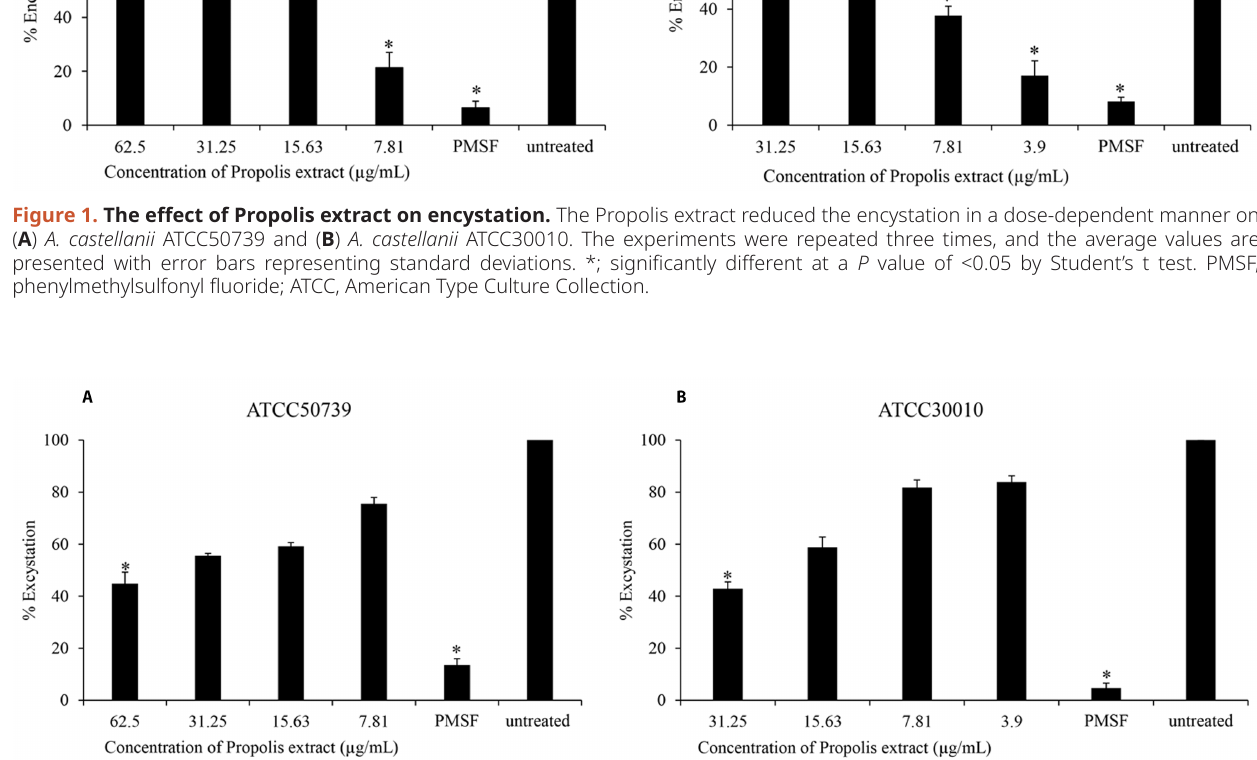
Figure 2. The effect of Propolis extract on excystation. Propolis extract reduced the excystation on ( A ) A. castellanii ATCC50739 and ( B ) A. castellanii ATCC30010. The experiments were repeated three times, and the average values are presented with error bars representing standard deviations. *; significantly different at a P value of <0.05 by Student’s t test. PMSF, phenylmethylsulfonyl fluoride; ATCC, American Type Culture